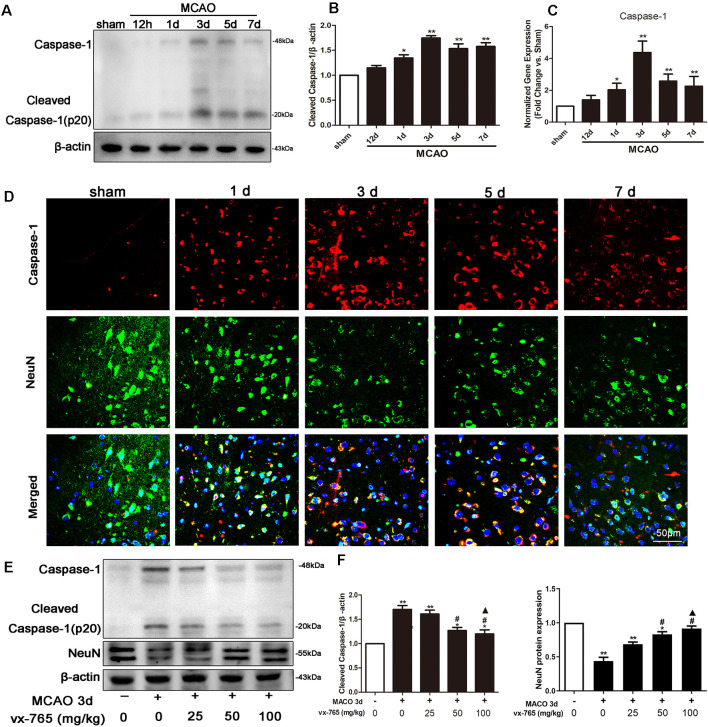
Middle cerebral artery occlusion (MCAO)-induced caspase-1 expression in rats. (A,B) Western blotting analysis of the expression of caspase-1 protein in the peri-infarct area. (C) RT-qPCR of caspase-1 mRNA at 12 h to day 7 after MCAO. (D) Representative images of fluorescent staining of caspase-1 (red) and the neuron marker (NeuN, green) in the ipsilateral thalamus after MCAO from day 1 to day 7. Scale bar = 50 μm. (E) Western blot analysis of caspase-1 and NeuN proteins at different concentrations of vx-765. (F) Combined western blotting statistics. All data are expressed as means ± SEM, *P < 0.05 and **P < 0.01, vs. sham, #P < 0.05, vs. vehicle; ▲P > 0.05, vs. vx-765 50 mg/kg, n = 4 per group.